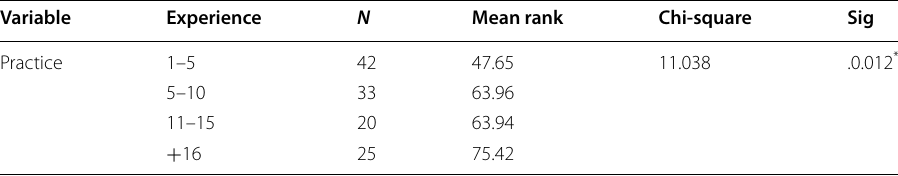
Table 8 Kruskal‑Wallis test for teaching experience and assessment conception